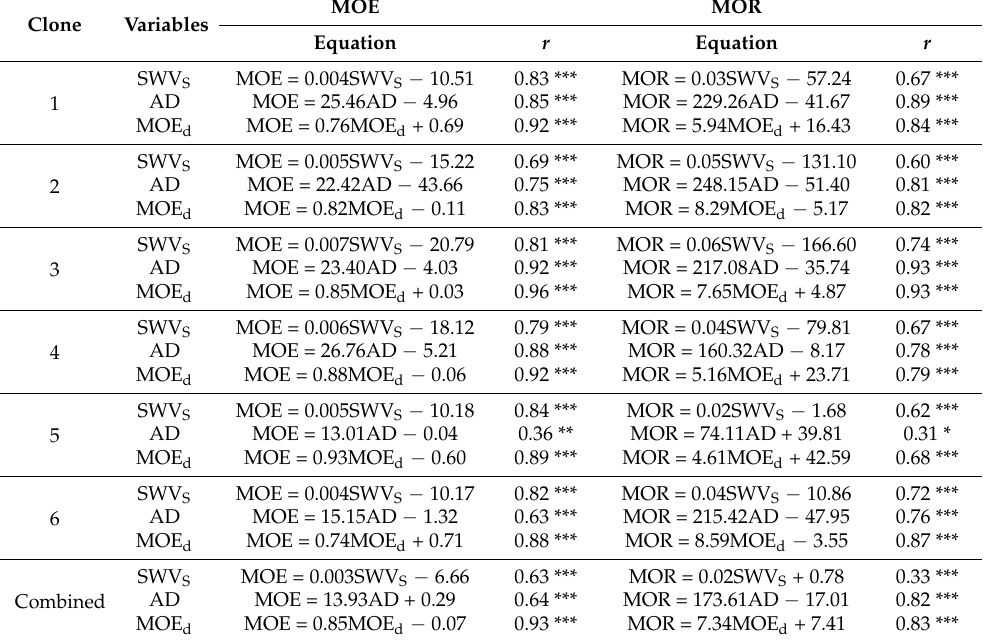
Table 7. Prediction models of static bending properties (MOR and MOE) based on stress wave velocity of specimens (SWV S ), air-dry density (AD), and dynamic modulus of elasticity (MOE d ) for each Eucalyptus clone and all clones combined.